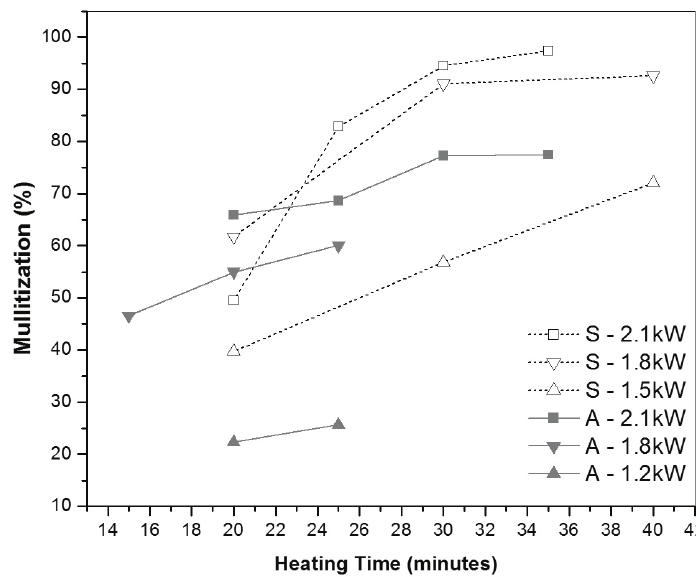
Figure 3. Mullitization as a function of time for samples A and S sintered at 1.2, 1.8 and 2.1 kW.